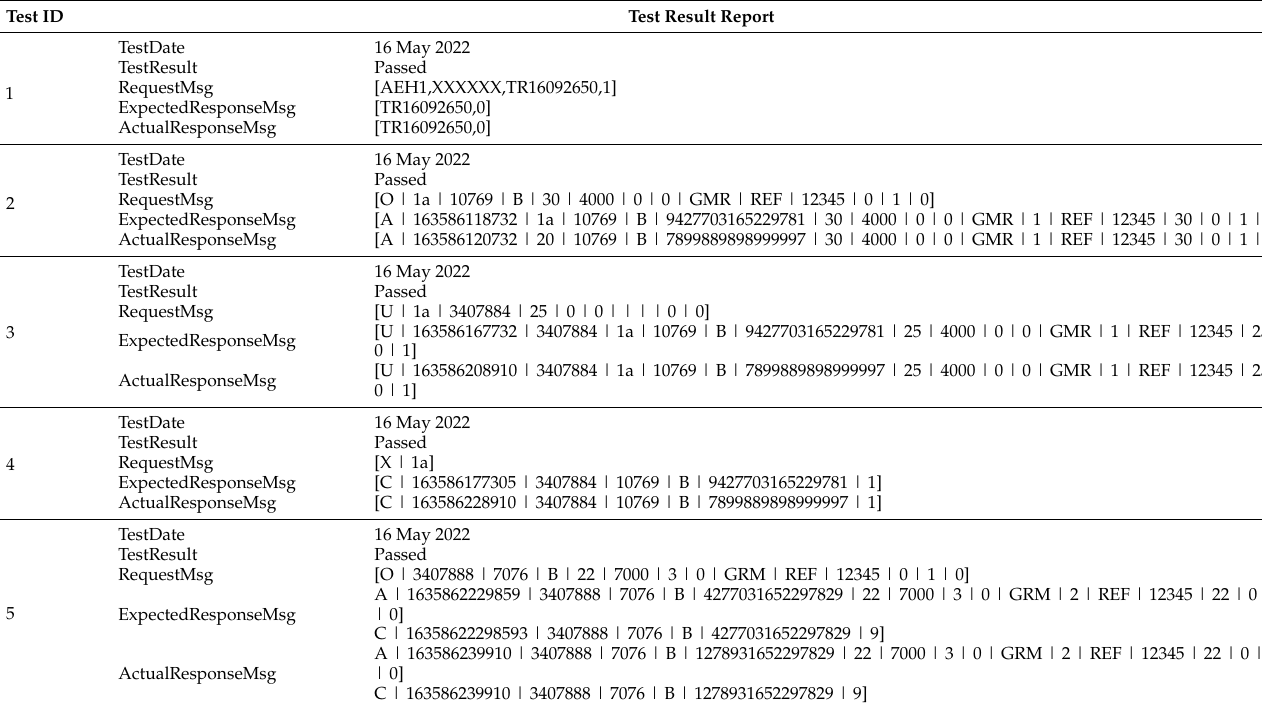
Table 7. Selected produced test result